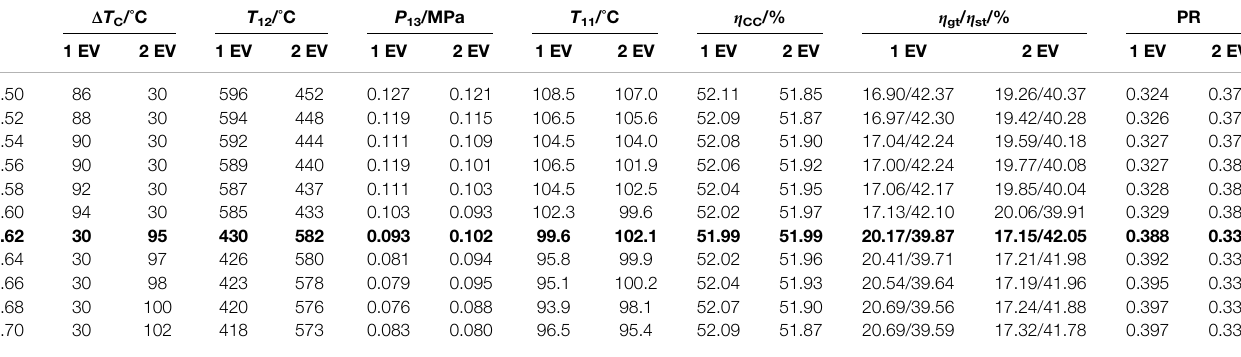
TABLE 3 | Results of the compression ratio in the range of 2.5 –